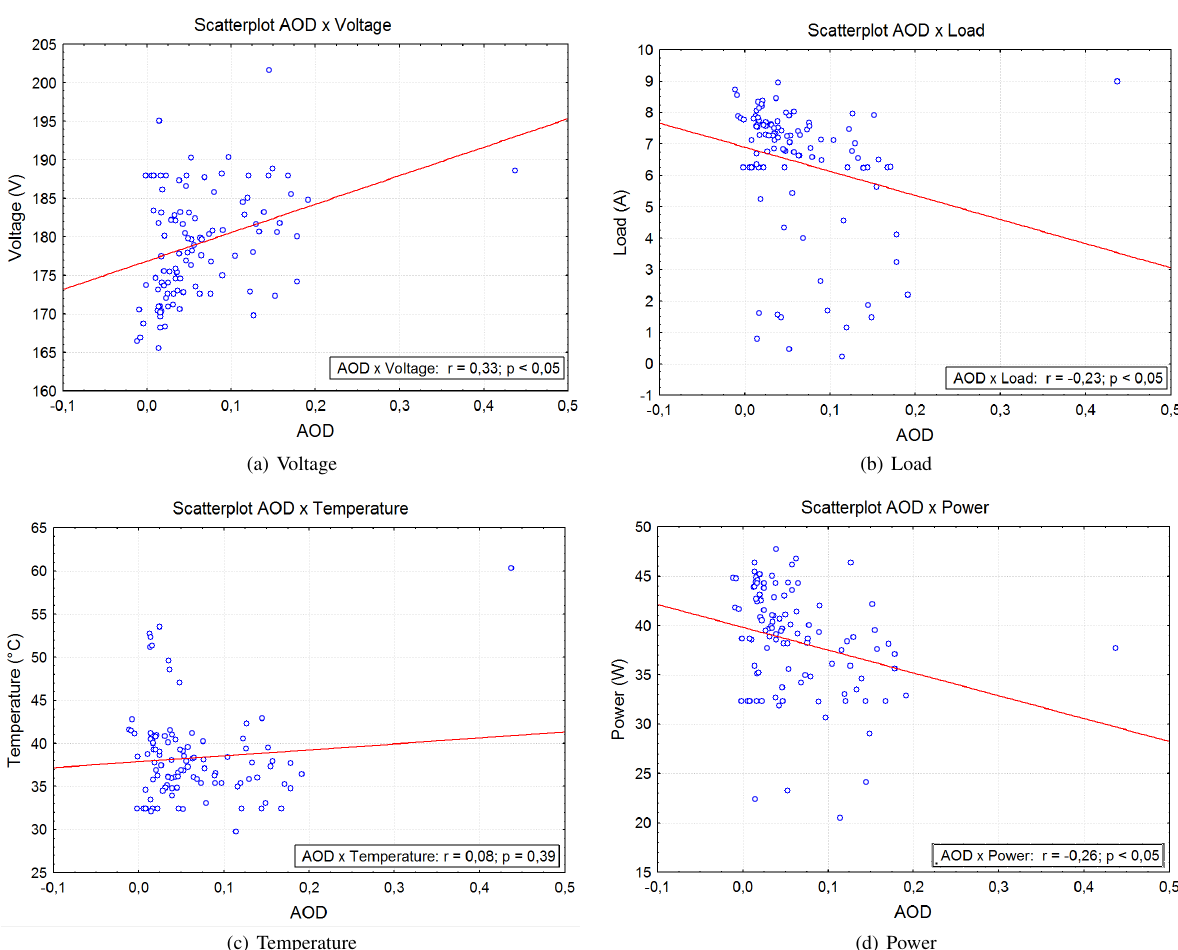
Figure 4. Some parameters’ behavior graphs over time